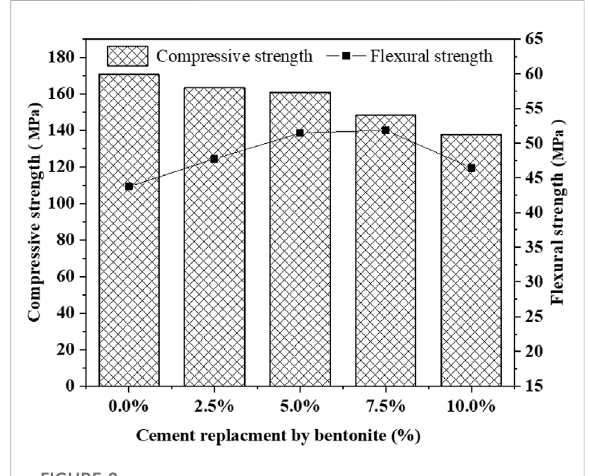
FIGURE 8 Compressive strength and fl exural strength of